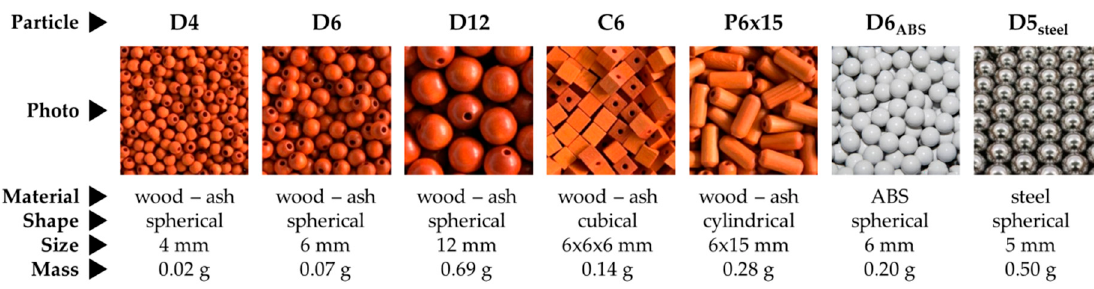
Figure 1. Particulate materials and their basic properties.